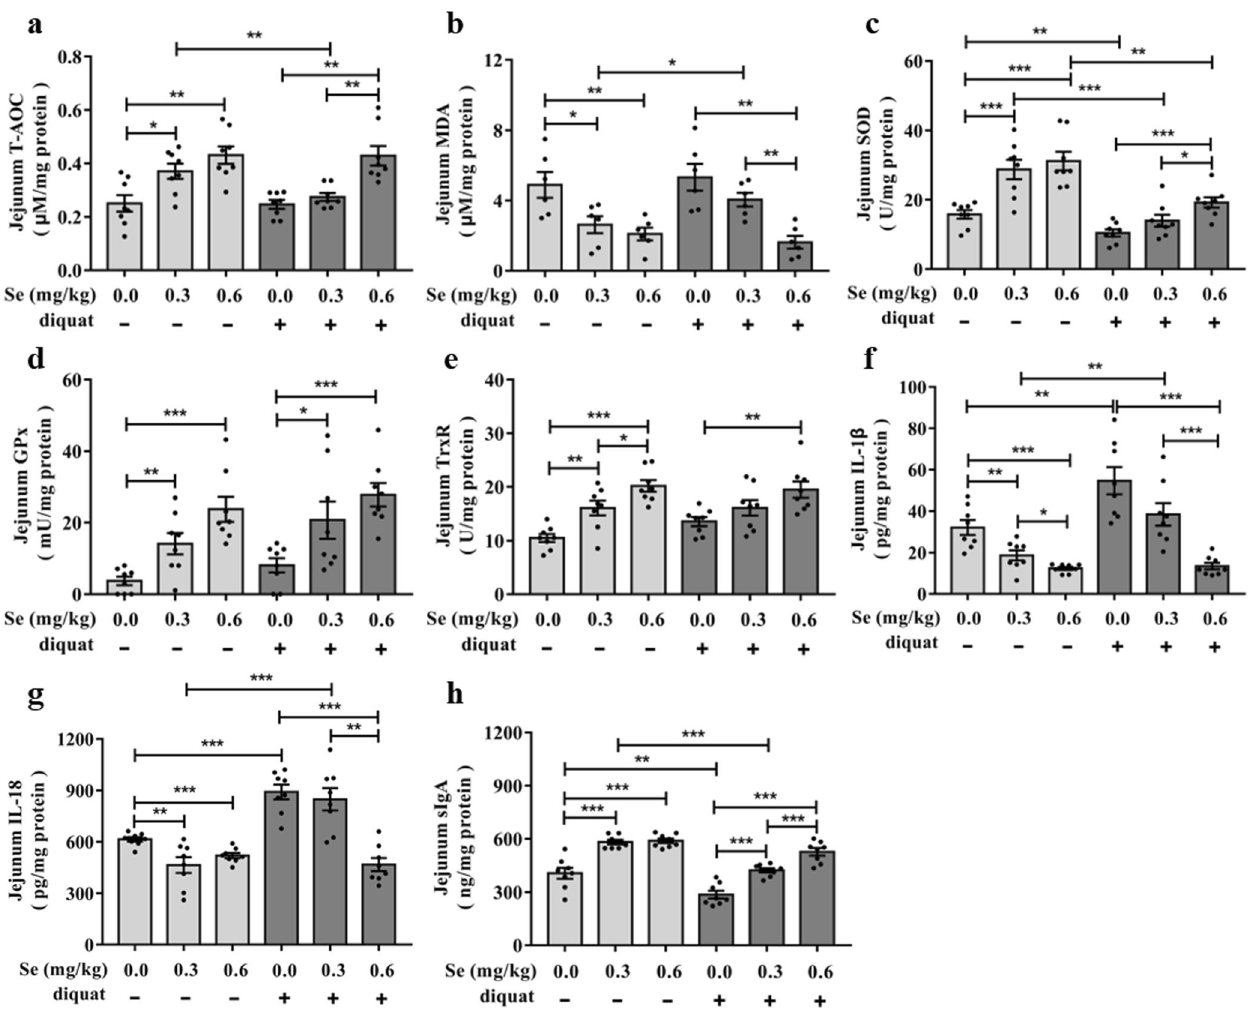
Fig. 3 Effects of different dietary SeNPs supplementation on the antioxidant capacity and immune response in diquat-exposed mice. a – e Oxidative stress response including T-AOC ( a ), MDA ( b ), SOD ( c ), GPx ( d ), TrxR ( e ) ( n = 8). f Level of IL-1 β in the jejunum of mice ( n = 8). g Level of IL-18 in the jejunum of mice ( n = 8). h Level of sIgA in the jejunum of mice ( n = 8). Data are expressed as mean ± SEM. * P < 0.05; ** P < 0.01; *** P <